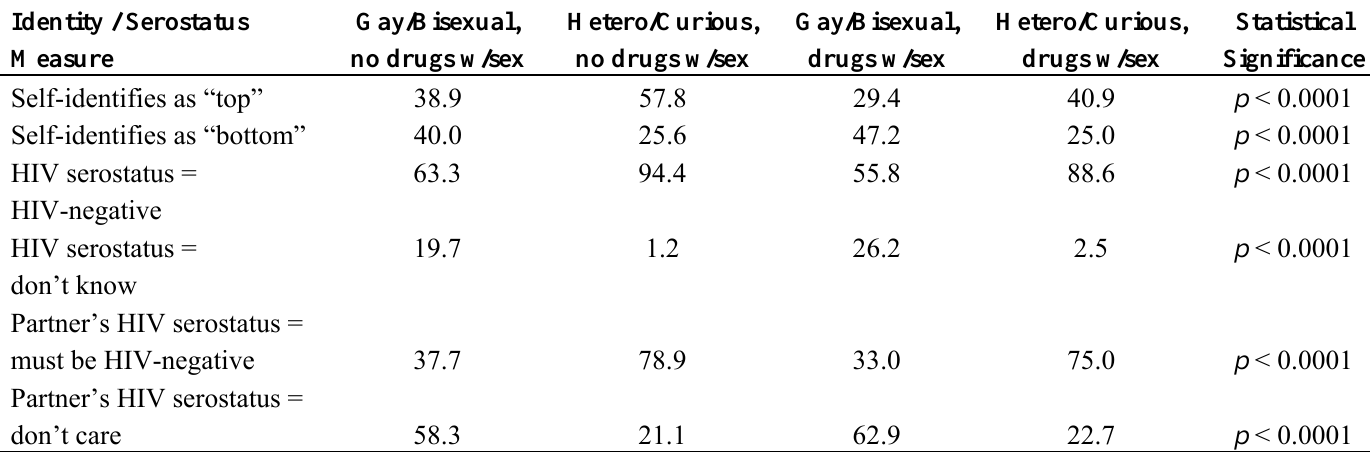
Table 3. Differences in Sexual Role Identity and HIV Serostatus Measures, by Sexual Orientation and Drug Use